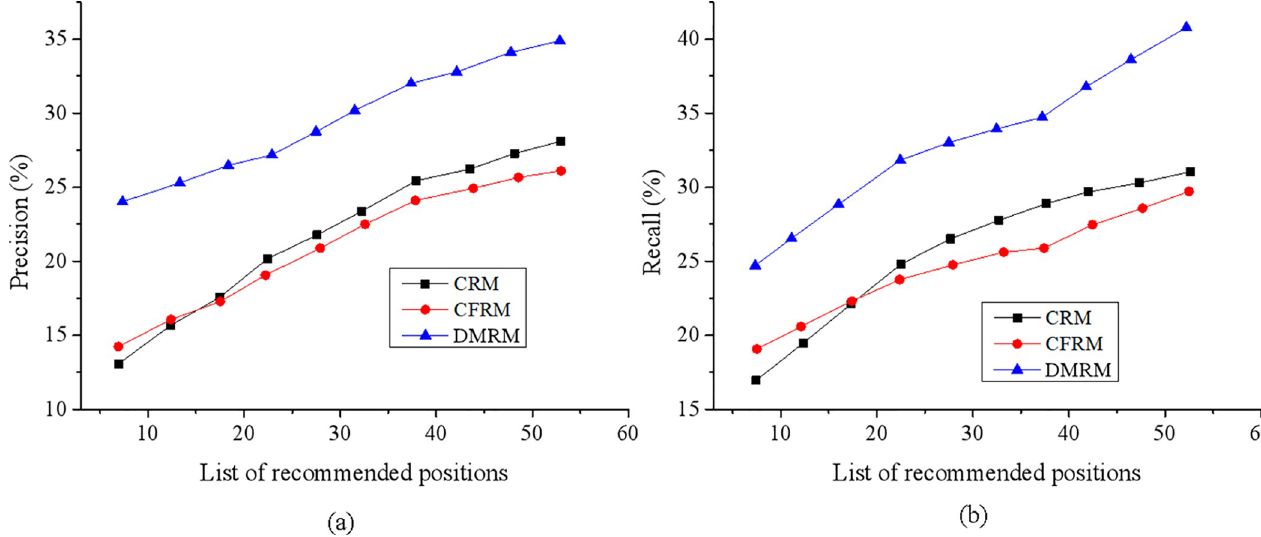
Fig 4. Comparison of talent recommendation results: (a) precision; (b)